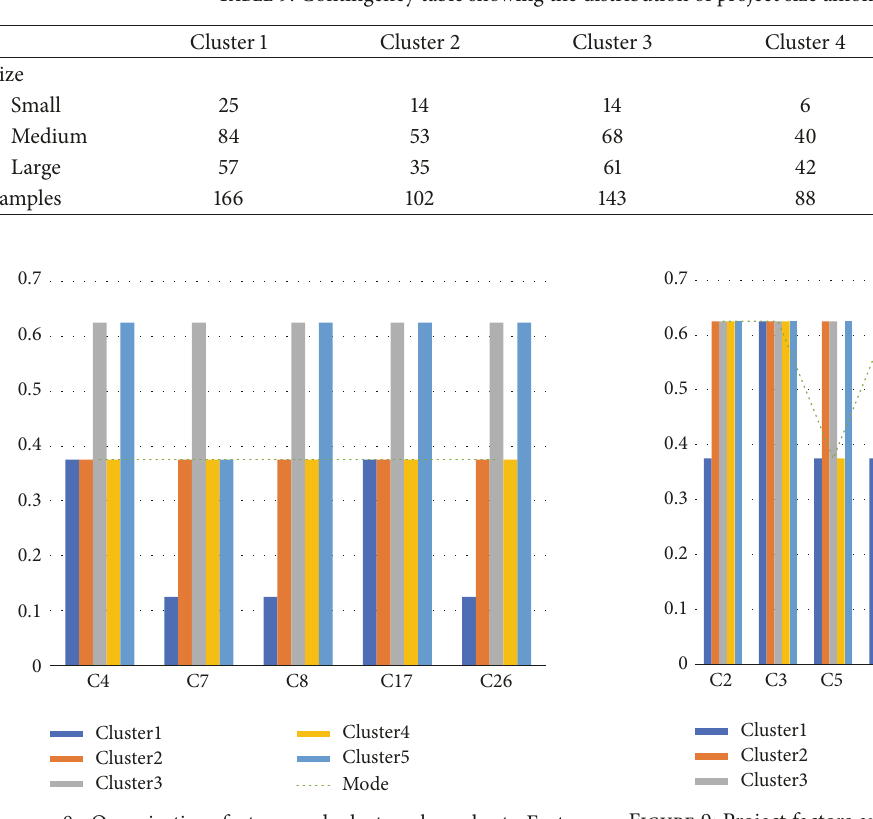
Figure 8: Organization factors and clusters bar chart. Factor importance average score of each cluster plotted against the mode of the global survey.